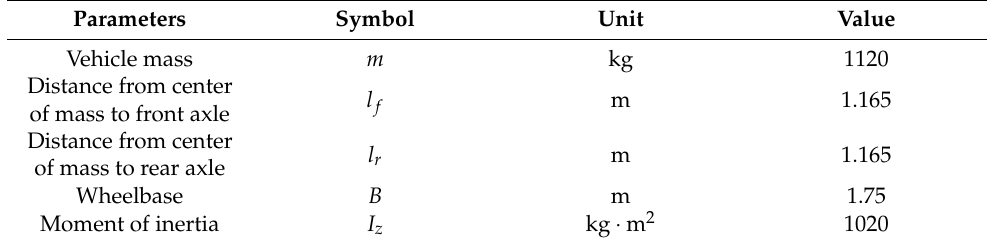
Table 1. Vehicle